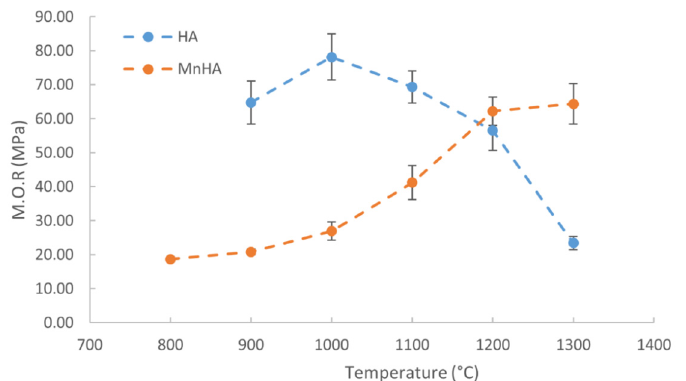
Figure 6. Mechanical properties of sintered HA and MnHA pellets as a function of temperature. Average M.O.R values are plotted ± standard error ( n ≥ 4).